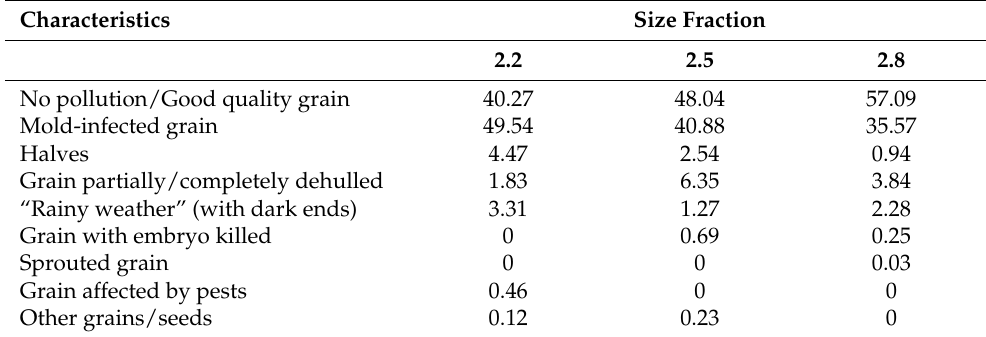
Figure 2. Examples of the types of BOJOS cultivar grain damages. Table 1. Contaminant content in the examined size fractions of malting barley of BOJOS variety [%].